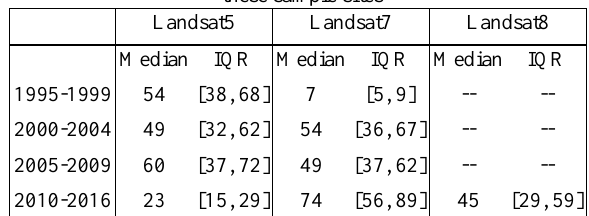
Table1. Summary of available Landsat image counts among these sample sites